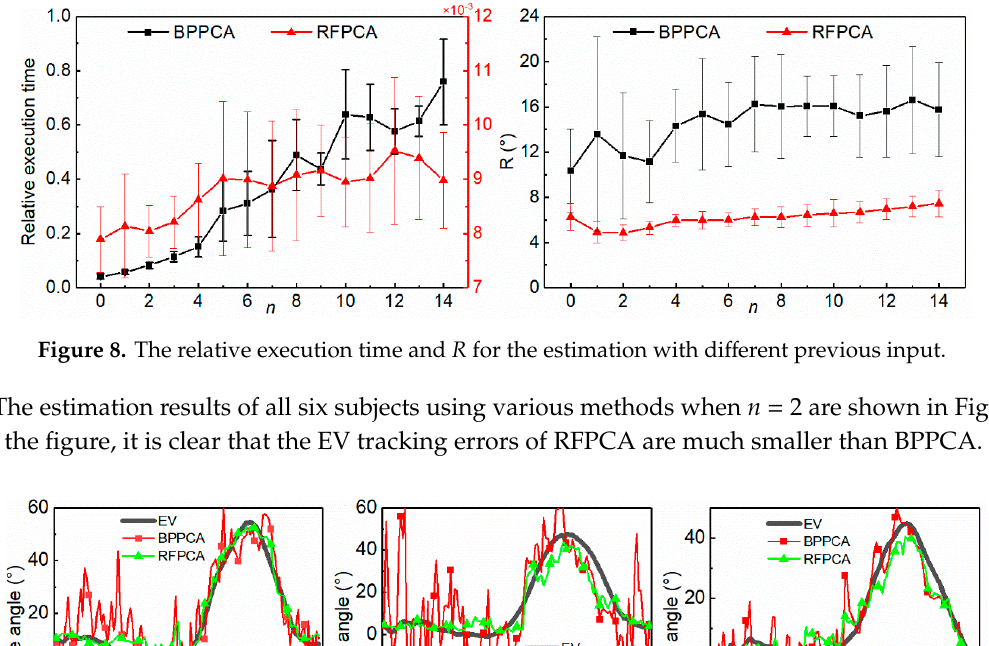
Figure 10. The evaluation metric of different models for different subjects when n = 2.